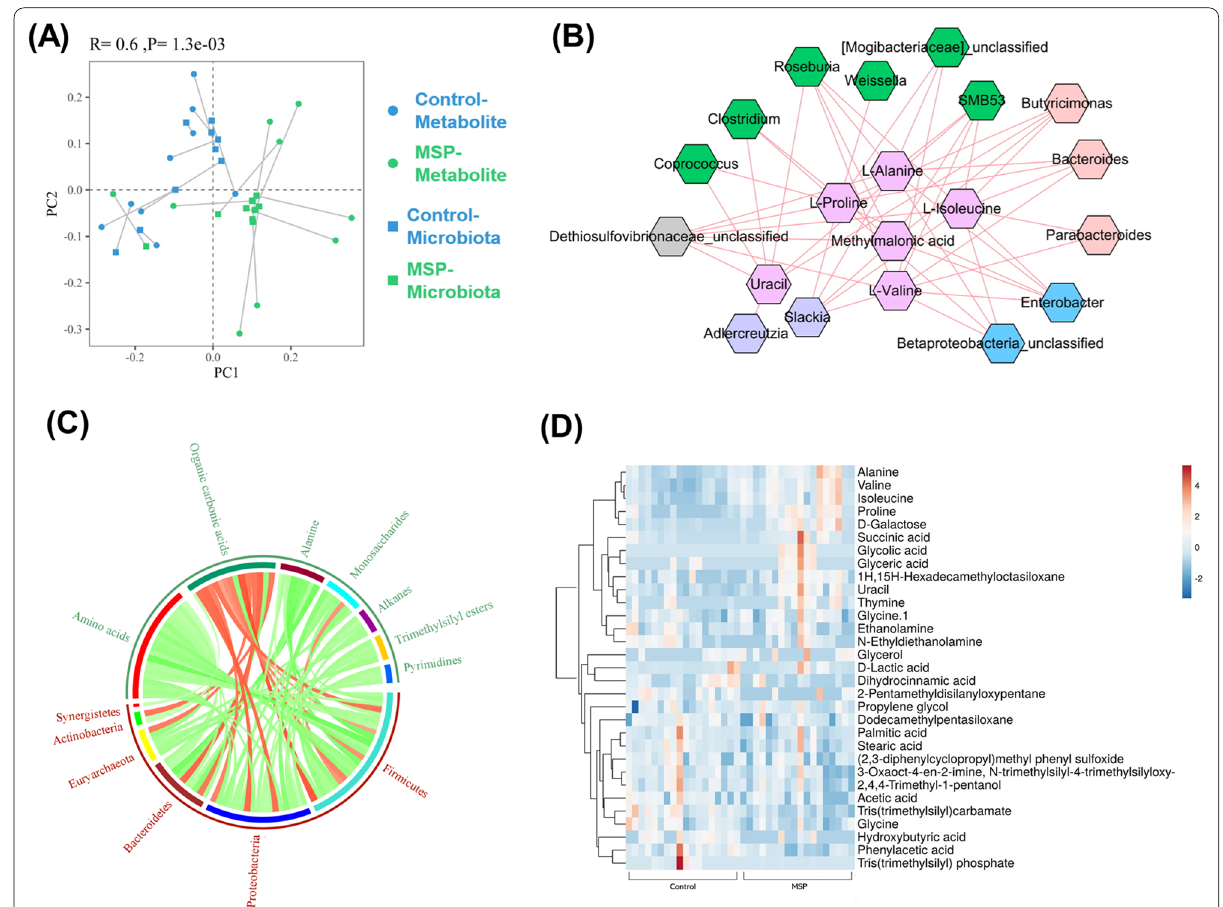
Fig. 5 Correlation analysis between fecal microbiota and metabolites. The depiction of similarity analysis and SparCC correlation analysis results. A PA, the length of the lines connecting two locations reflects how well two datasets samples agree. The correlation coefficient R ranges from 0 to 1, and the closer it is to 1, the more similar the two datasets are. B Correlation between the functional metabolites and fecal microbiota. The pink nodes represent the functional metabolites and the other nodes of bacteria were grouped with different colors (functional false discovery rate (FDR) < 0.05). C SparCC correlations between bacteria and metabolites are depicted in a Circos plot. Red or green lines indicate positive or negative correlations. D Heatmap represent metabolites concentrations correlated with each